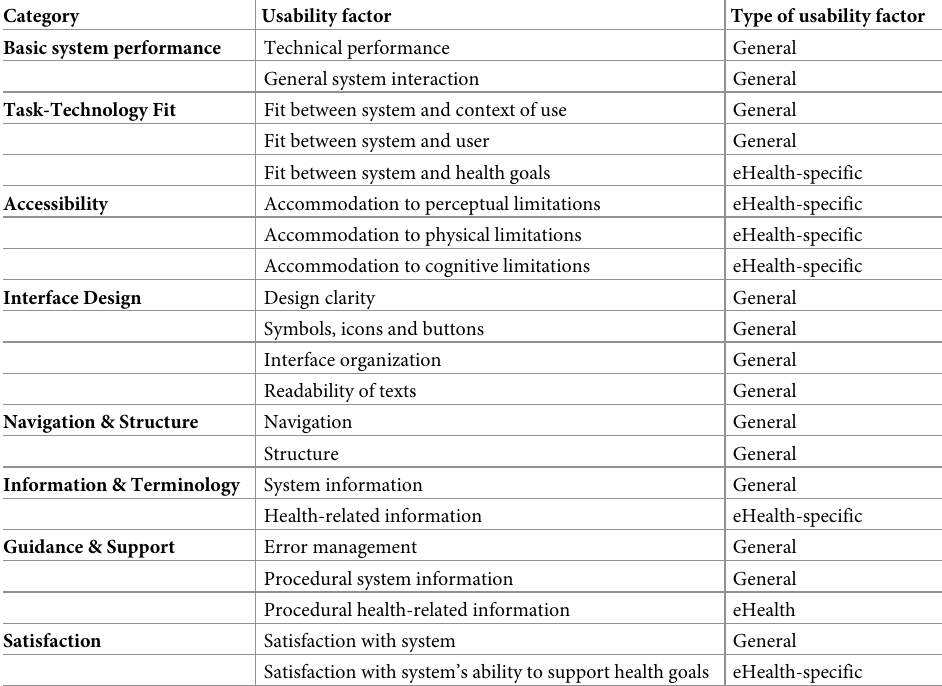
Table 1. Usability ontology for eHealth (from Broekhuis et al.